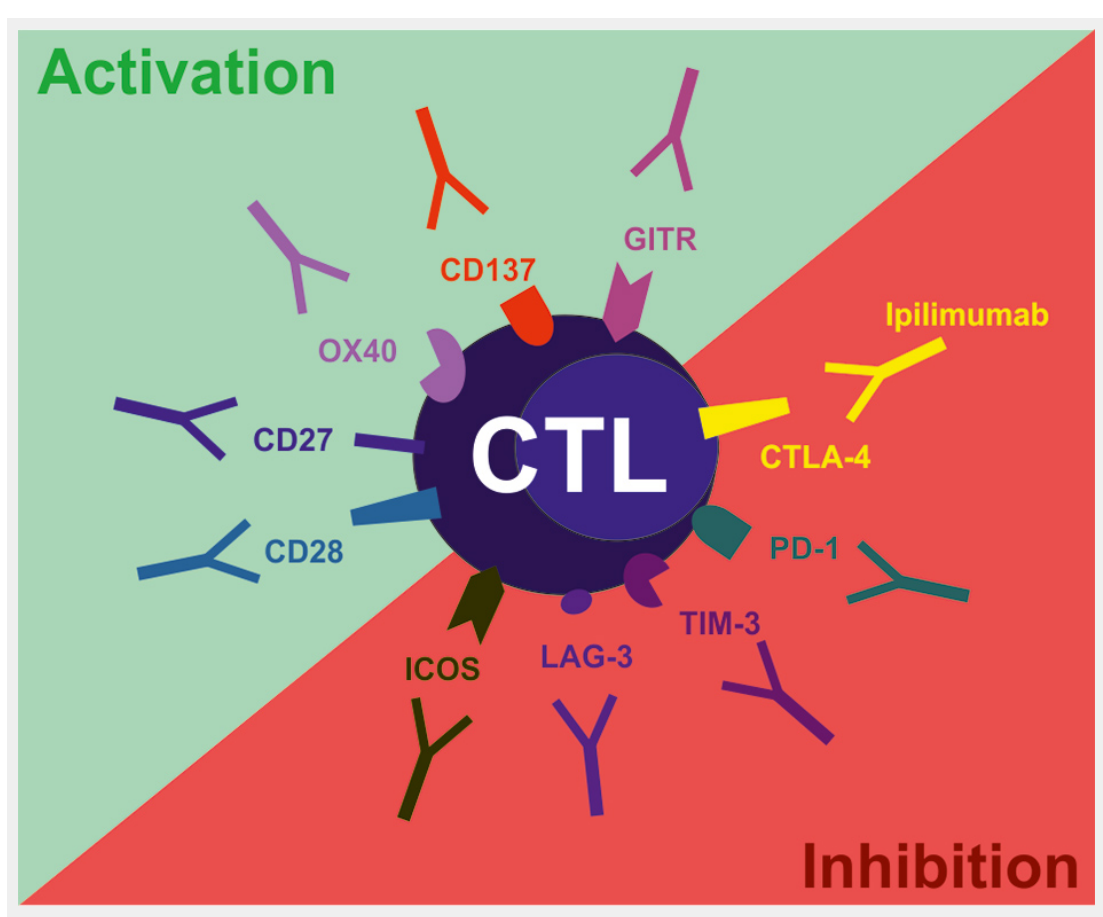
Figure 1 Examples of co-stimulatory and co-inhibitory molecules on T cells suitable for targeting with agonistic and blocking antibodies, respectively. CTLA-4, cytotoxic T lymphocyte antigen-4; PD-1, programmed cell death 1; TIM-3, T cell immunoglobulin and mucin domain-containing protein 3; LAG-3, lymphocyte activation gene 3; ICOS, inducible T cell co-stimulator; GITR, glucocorticoid-induced TNF family related gene; CD, cluster of